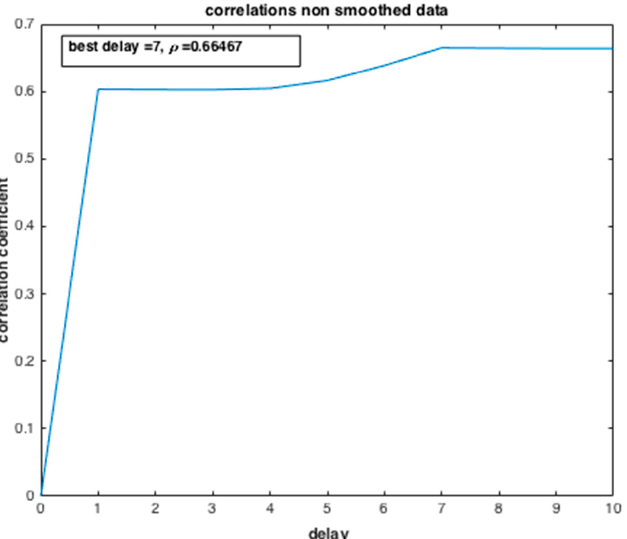
Figure 21. Evolution of the correlation coefficient of the number of suspected cases (S) and the number of infected cases (I).